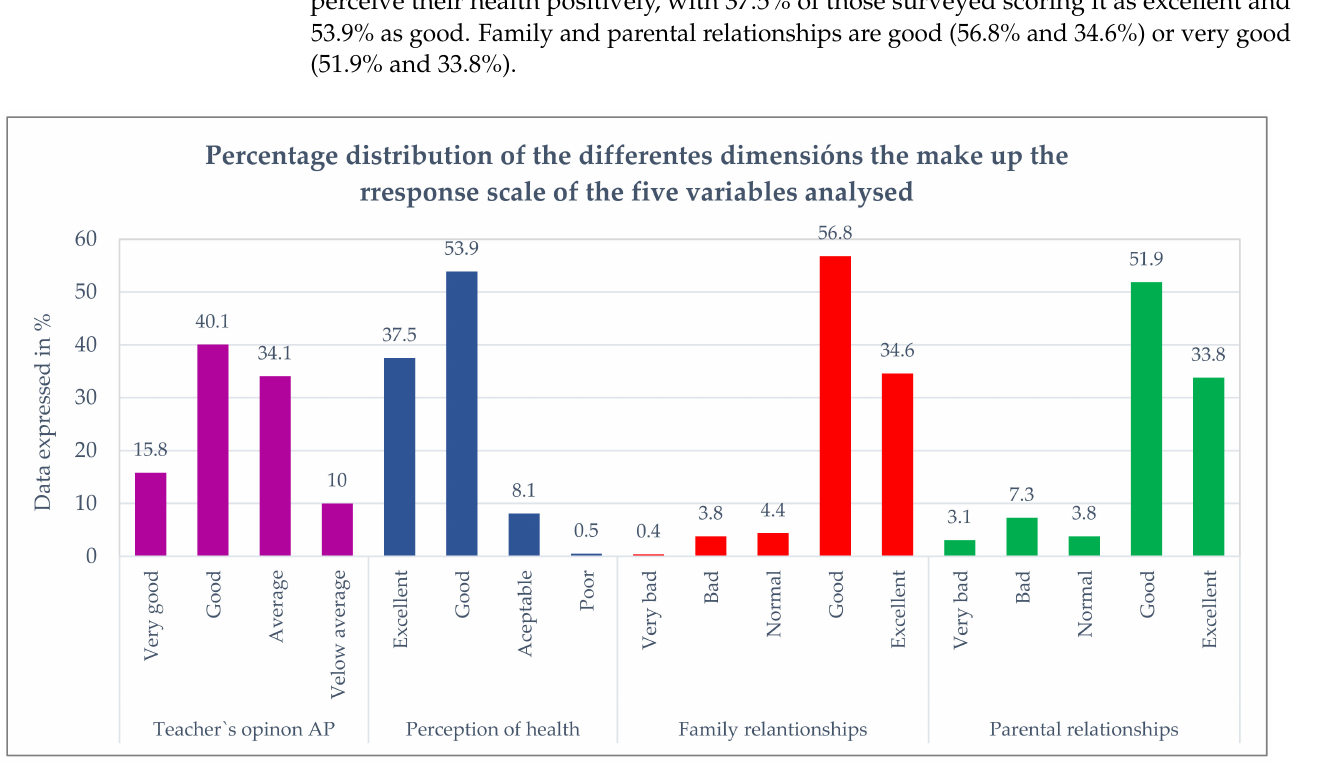
Figure 1. Descriptive data for the variables teacher’s opinion of AP, perception of health, family relationships and parental